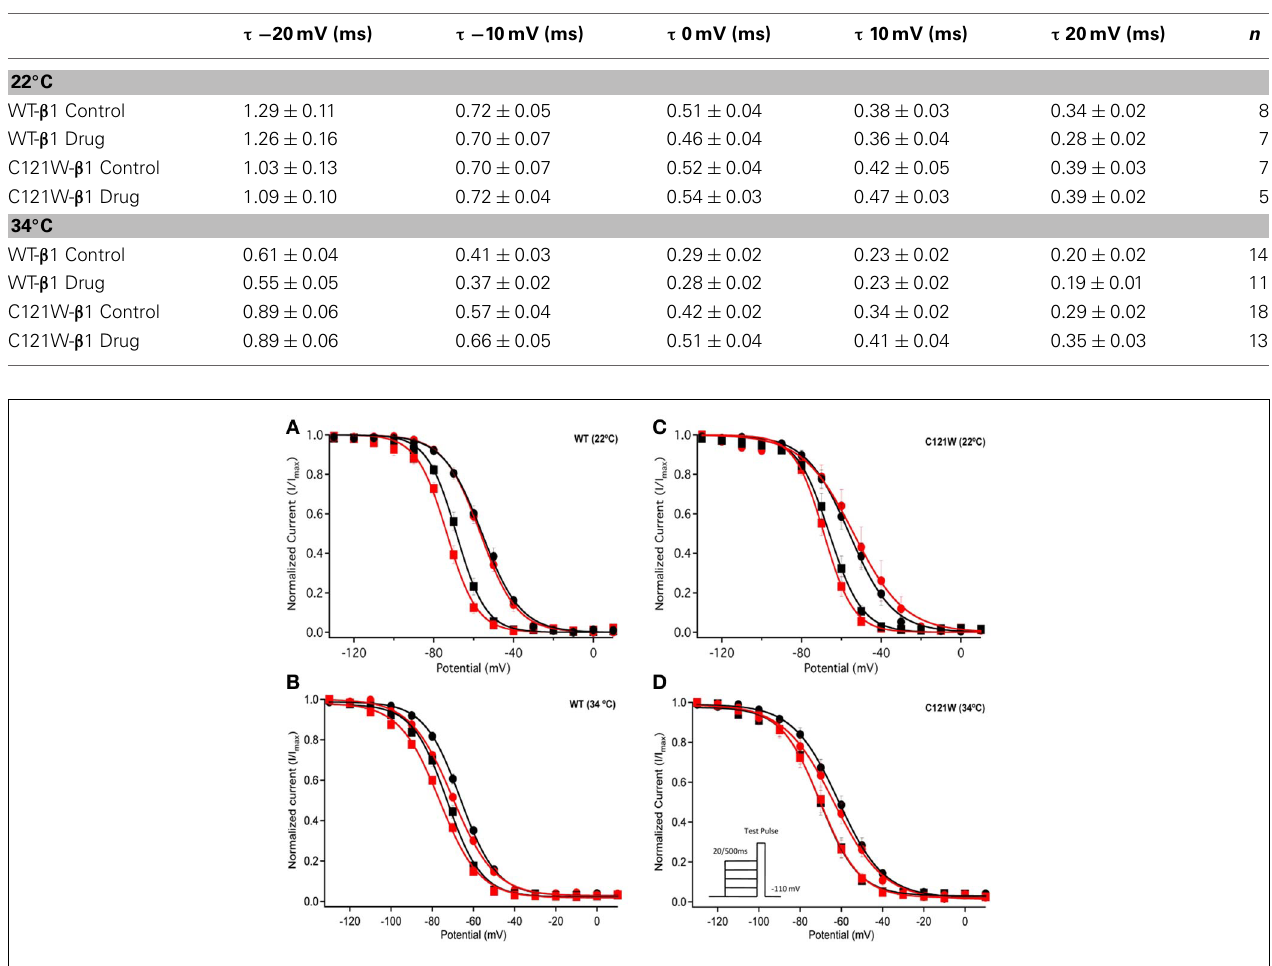
FIGURE 2 | Steady-state fast inactivation. Normalized current is plotted against a range of prepulse potentials (mV). Steady-state fast inactivation was elicited by both 20ms prepulse durations (filled circles) and 500ms prepulse durations (filled squares). For both WT at 22 ◦ C and 34 ◦ C (A,B)